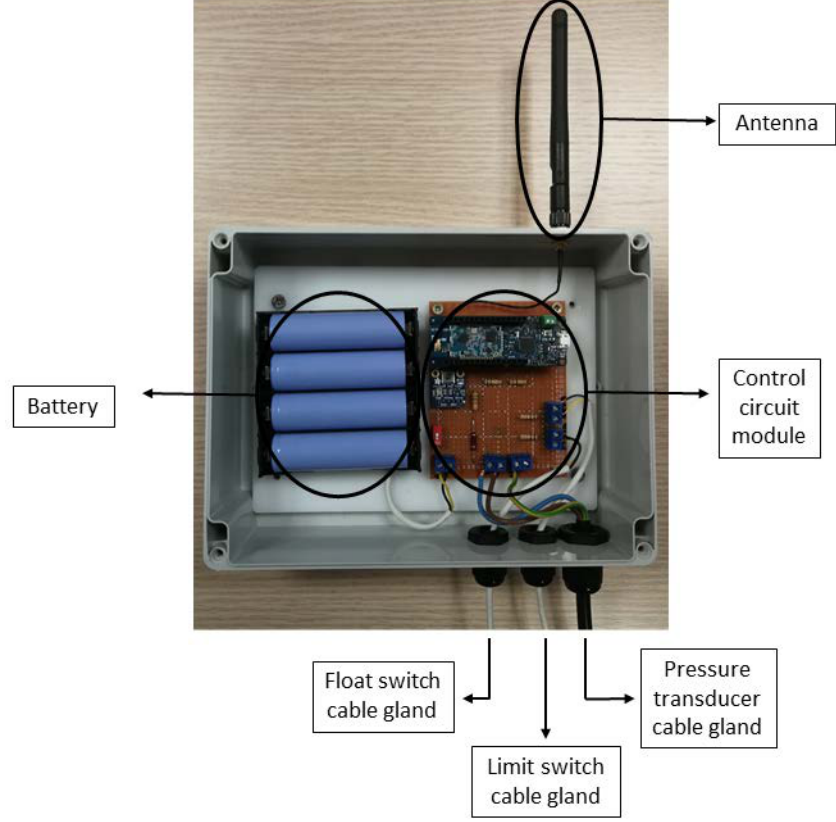
Figure 7. Internet of Things pressure monitoring system (IPMS) electronics.